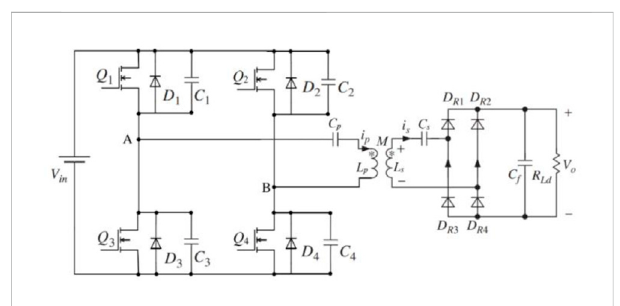
FIGURE 2 Topology of two-stage WPT system.